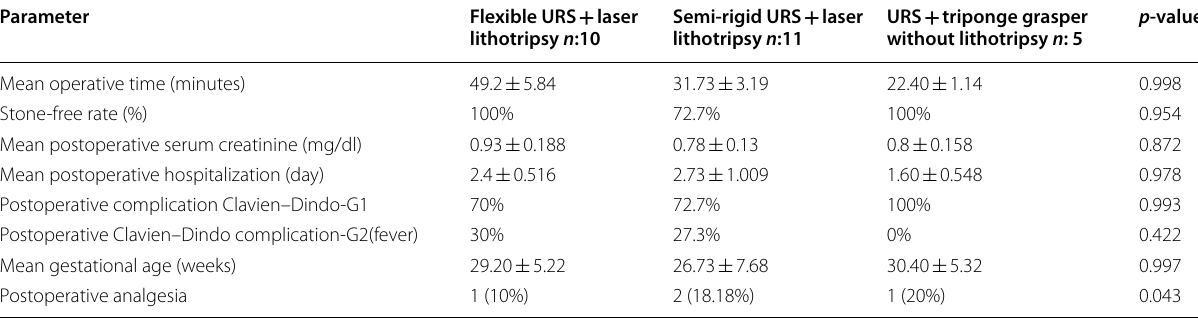
Table 2 Outcomes of Intraoperative and postoperative patient data in different groups Parameter Flexible URS